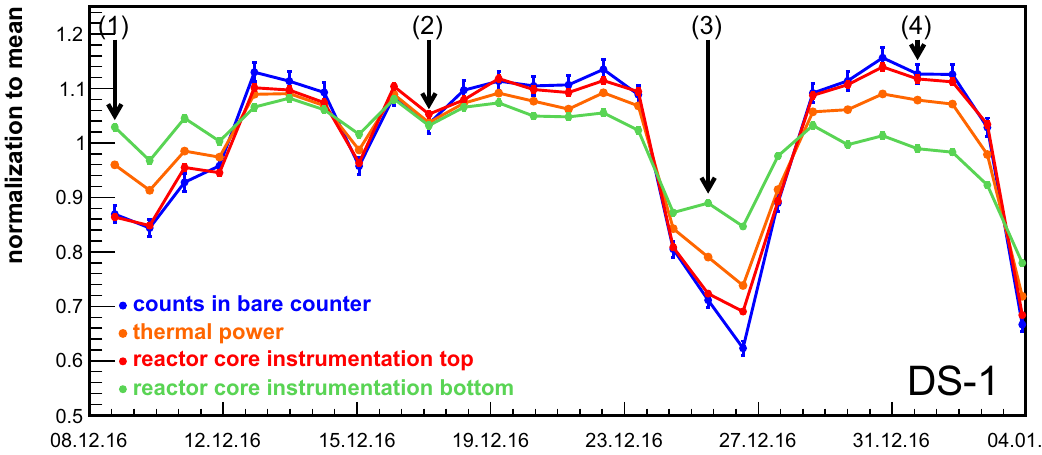
Fig. 15 DS-1 at the end of a reactor cycle; counts in bare BSS compared to the thermal power and the core instrumentation. The arrows indicate the days, where the thermal power distribution along the z-axis is shown in Fig.